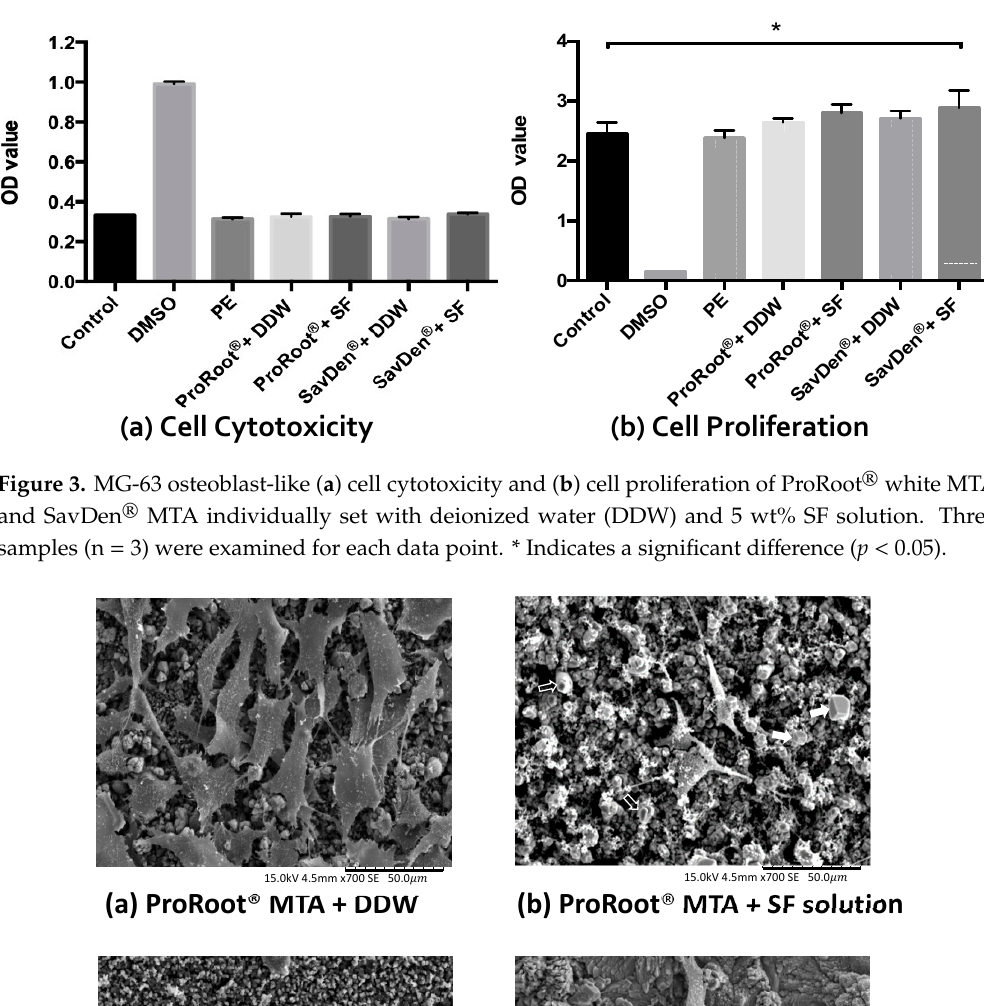
Figure 4. The SEM micrographs demonstrated the morphological features and attachment of MG-63 osteoblast-like cells on surfaces of various set MTAs after hydration for one day and seeded for five